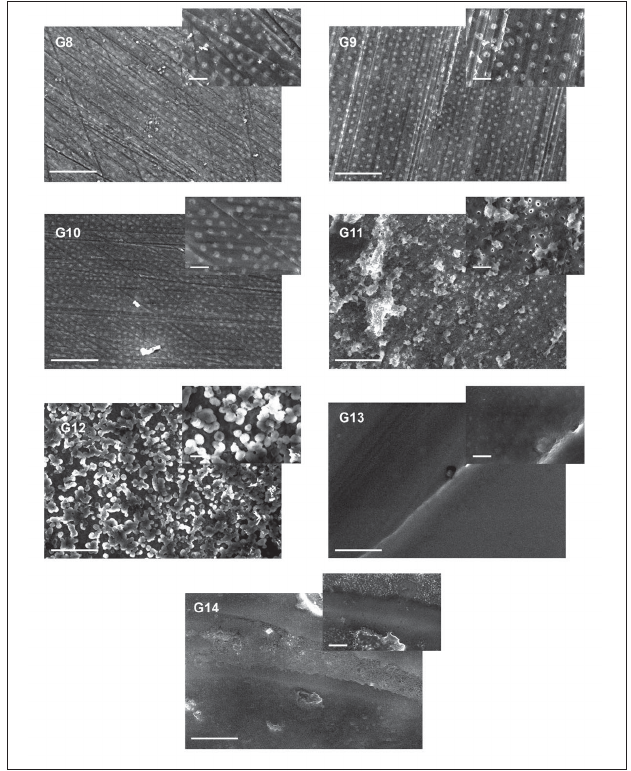
Fig. 2. LV-SEM micrographs of the dentin surfaces representative of all experimental groups. Main micrograph at 500X (bar = 50µm). Micrograph in detail at 2000X (bar =